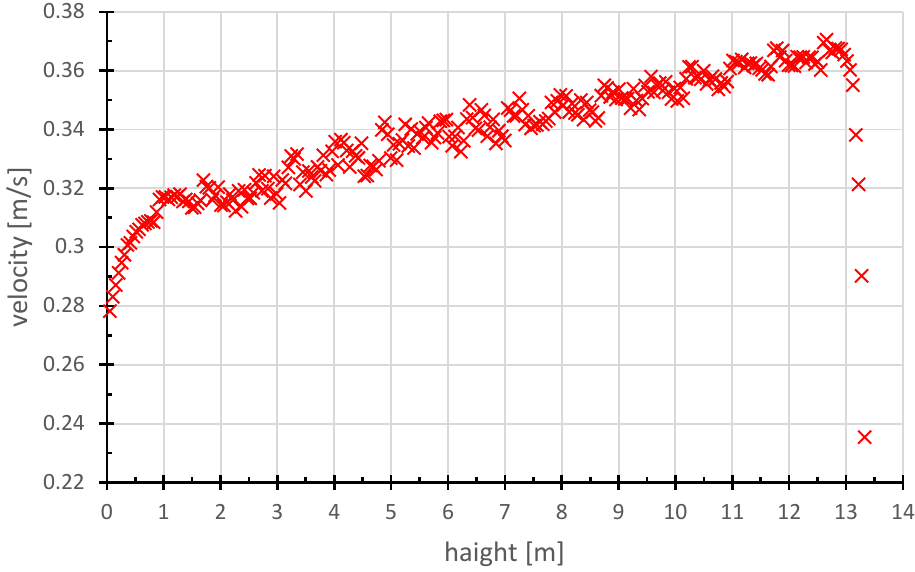
Figure 19. Graph of velocity distribution in ventilated gap along façade height winter extreme.